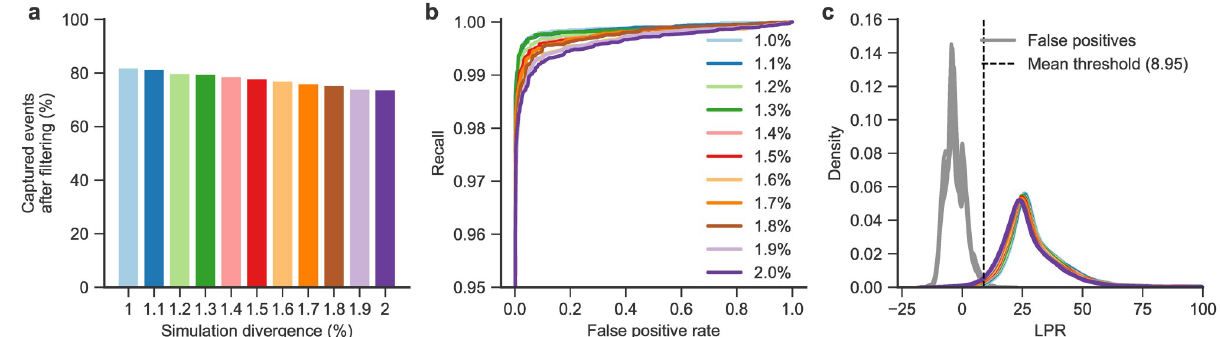
Fig 3. Distinguishing simulated events from background mutation clusters and setting alignment quality thresholds. (A) Percentage of events recaptured from simulations of template switch events alongside substitutions and indels using INDELible across a range of divergences. (B) Receiver operating characteristic (ROC) curves for discriminating between simulated template switch events and background mutation clusters. Simulations using divergence t from 1–2% in 0.1% steps are shown ( t value for each curve indicated by matching colour in part A). Note that the y -axis begins at 0.95 for clarity. (C) Density curves of LPRs for true positive (i.e. intentionally introduced) template switch events in colours corresponding to (A), and false positive events across all simulation values of t (background/chance mutation clusters) in grey. The mean LPR threshold required to achieve a FPR of 0.005 across simulations is shown as a dashed